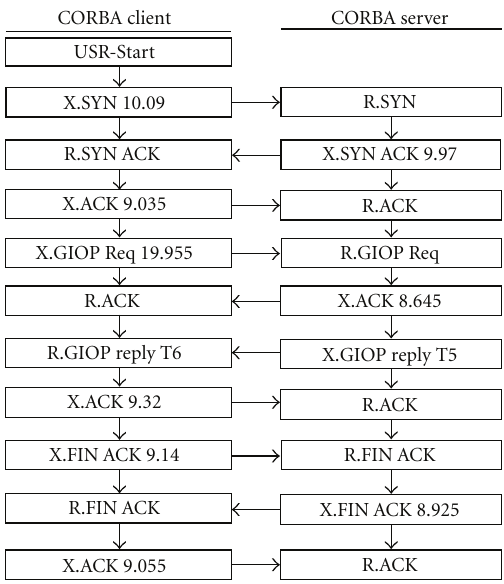
Figure 12: Measured latency values (in µ s) from CORBA IIOP transaction state diagram for hardware ORB.